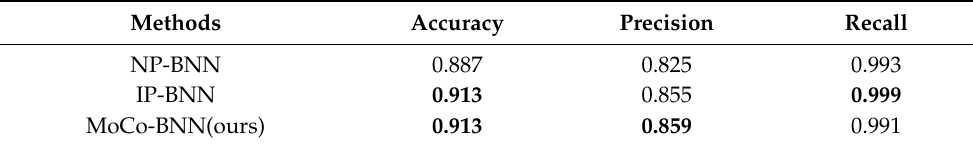
Table 1. Results for BNN patch-matching on SARptical with different pre-training methods.